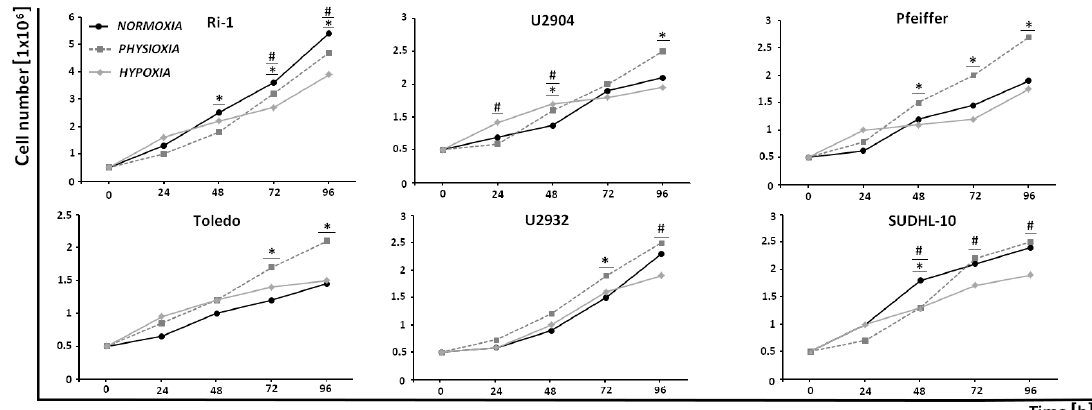
Figure 1. Cell growth of six lymphoma cell lines under hypoxia (1% O 2 ), physioxia (5% O 2 ), and normoxia (21% O 2 ). Evaluations were made at 24, 48, 72, and 96 h from the beginning of the incubation under various oxygen conditions. Representative data are from at least 2 parallels from three independent investigations. The symbol (*) indicates a significant difference between incubation in physioxia and normoxia considering a p -value <0.05, while symbol (#) indicates a significant difference between incubation in hypoxia and normoxia while considering a p -value <0.05; Student’s t -test.